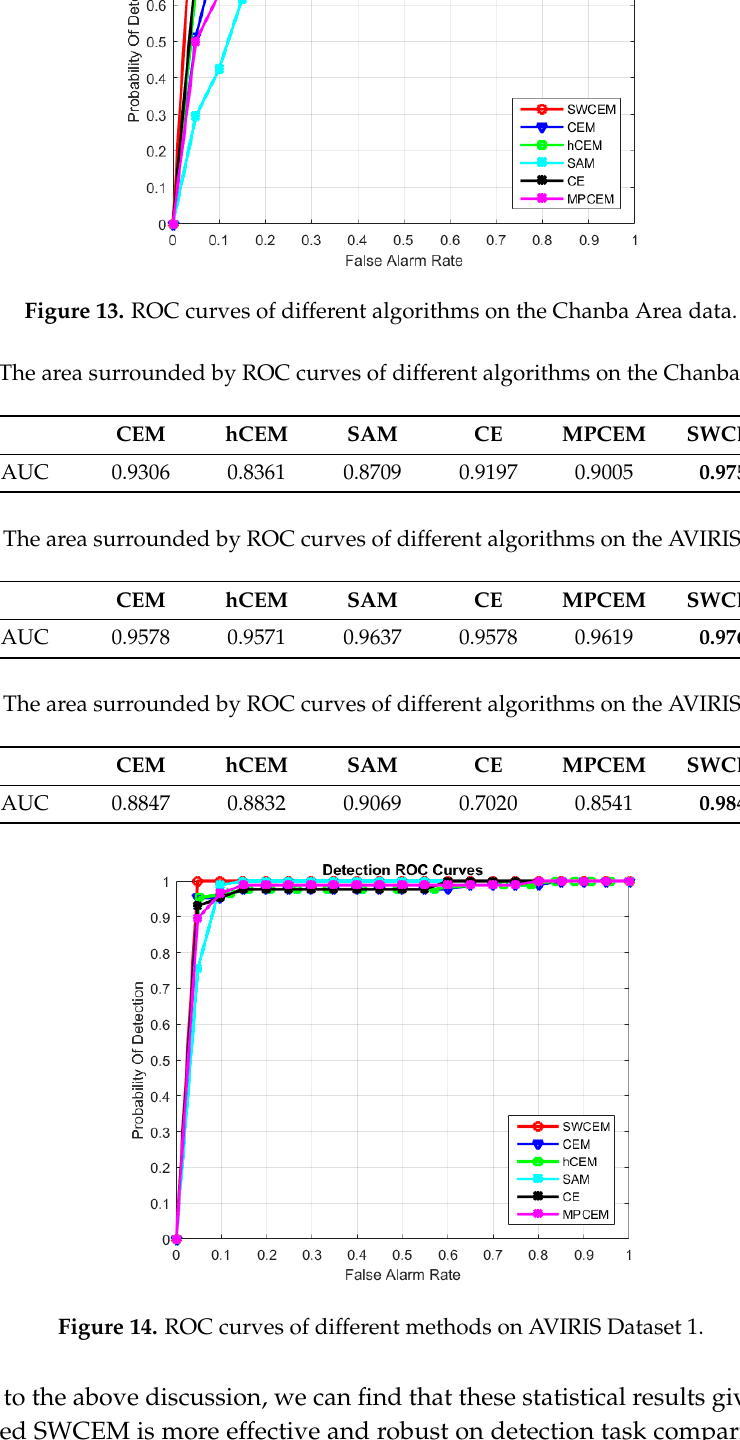
Table 3. The area surrounded by ROC curves of different algorithms on the Chanba Area data.